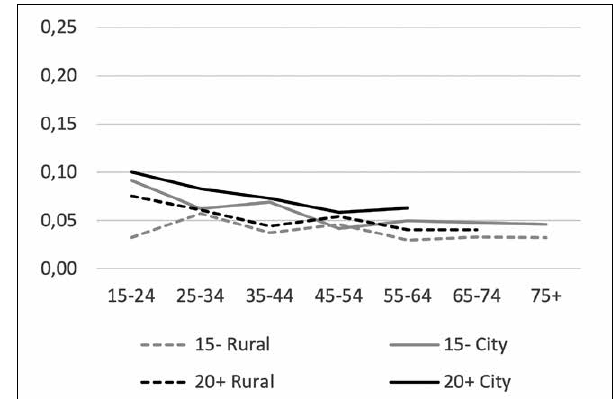
Figure 2b: Fixed-effects linear probability model of housing being a personal issue, 3-way interaction age, gender and urbanisation (rural vs city)